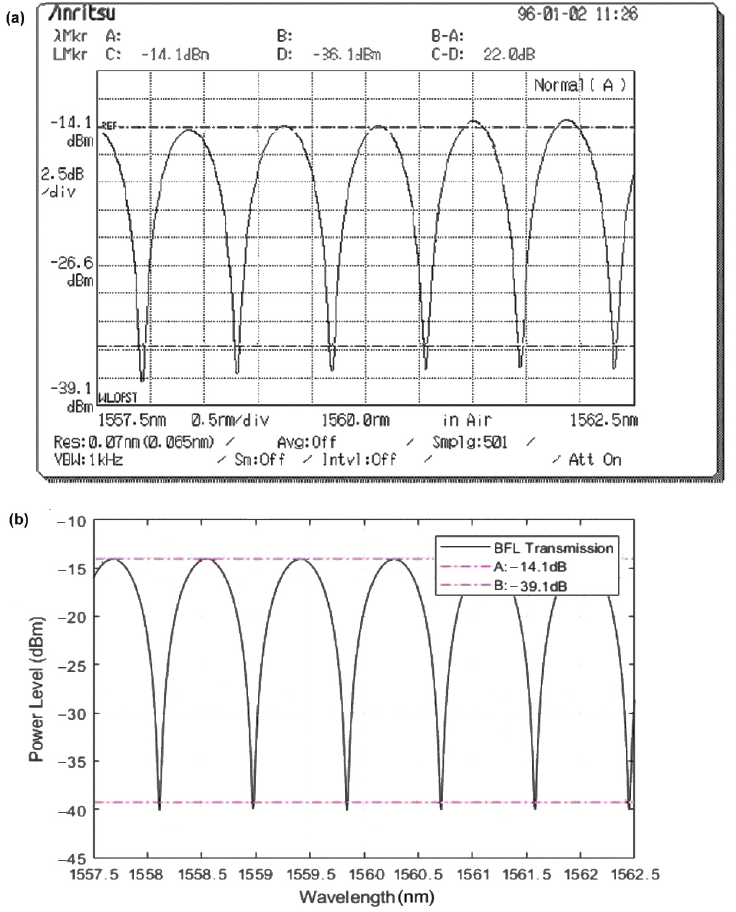
Figure 2. BFL response curves: ( a ) experimental and ( b ) theoretical. The upper and lower horizon- tal dash-dotted lines denote the maximum and minimum spectral responses, respectively, whose difference defines the Peak-to-Notch-Contrast Ratio